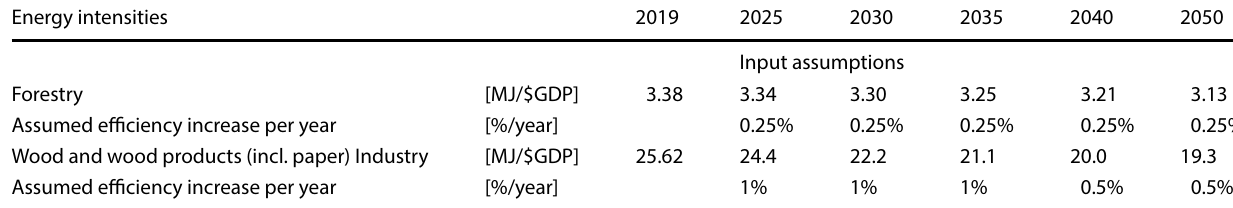
Forestry Wood and wood products (incl. paper) Industry